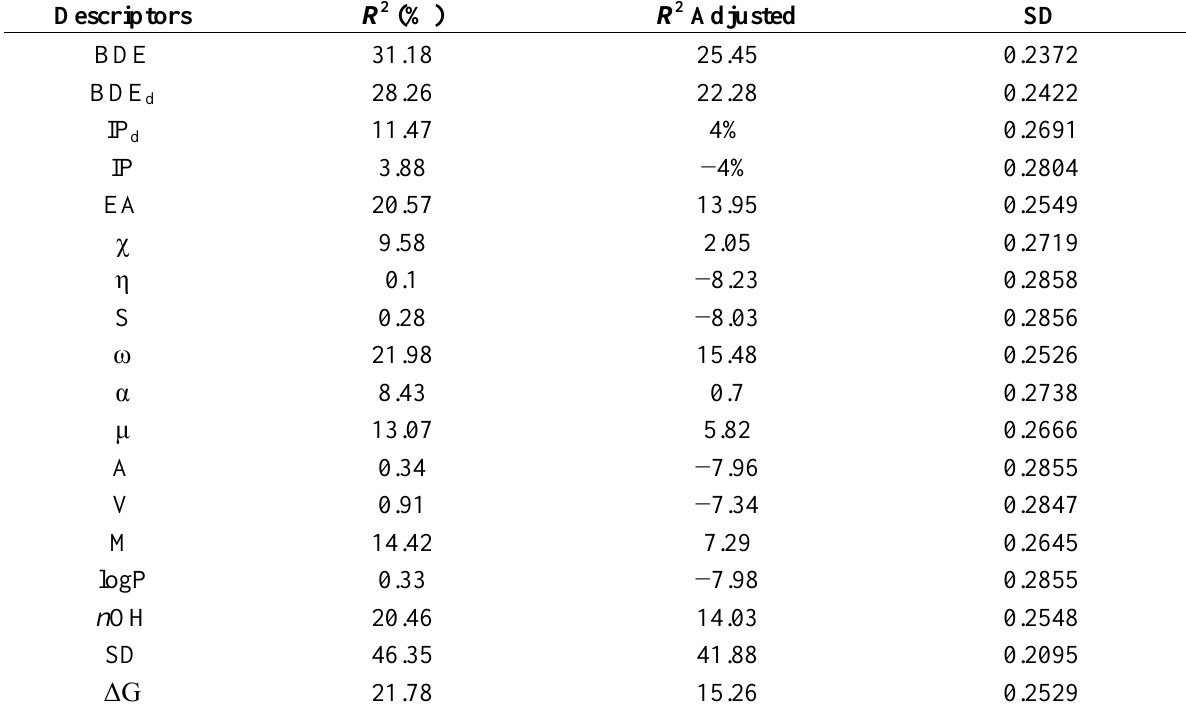
and calculated 50